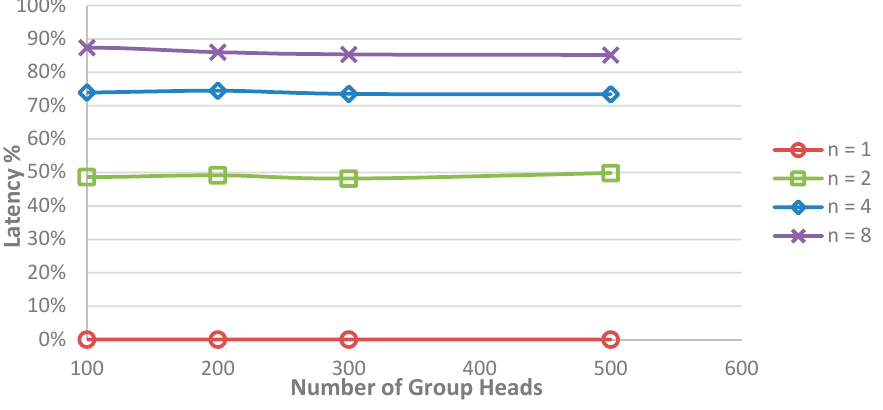
Figure 6. Average latency cost of detecting phenomena when using Lazy Update Technique (LUT).